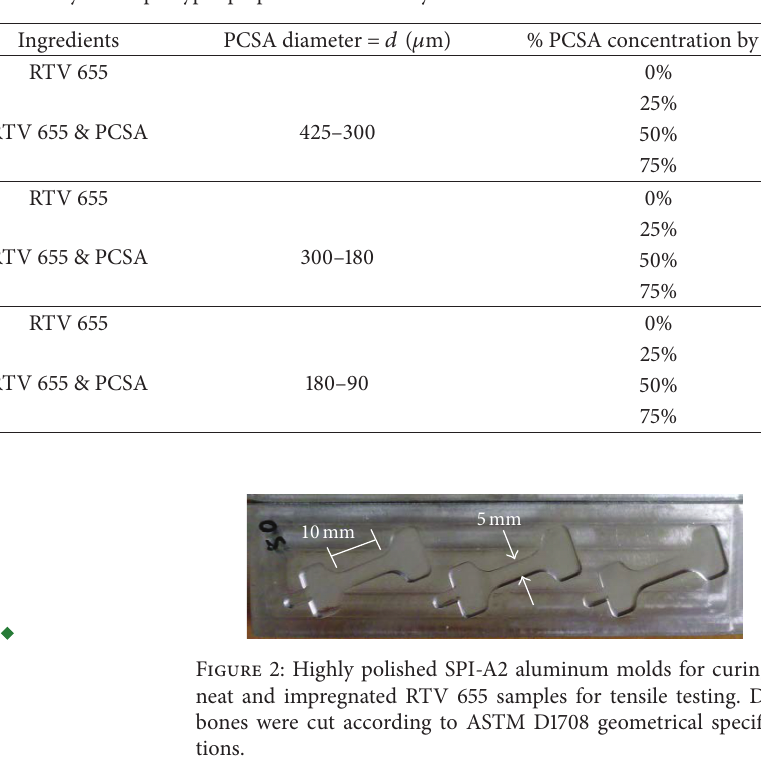
Table 1: Summary of sample types prepared for this study.